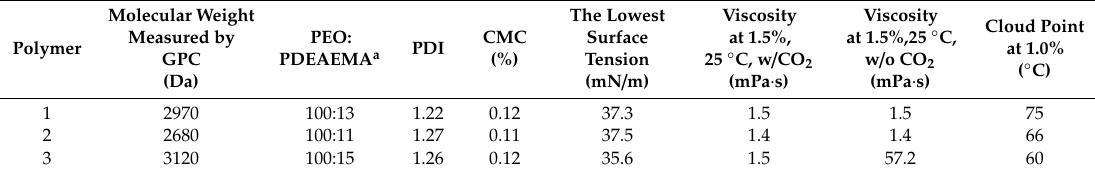
Table 1. Comparison of the properties of copolymers 1 , 2 , and